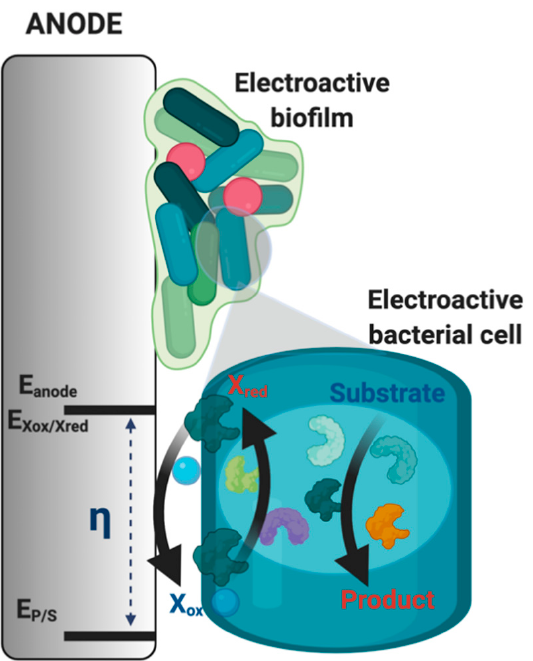
Figure 1. Pairing the microbial metabolism to an electrode surface (here, anode). Made with BioRender.com. As bacterial cells catalyze an intracellular redox reaction, generically represented as substrate to product, electrons flow to an eventual terminal electron acceptor such as redox-active protein on the cell surface or a biomolecule (X ox going to X red ) which is then re-oxidized at the electrode surface. Therefore, the potential of the anode (E anode ) will be determined by the electrochemical potential of the terminal electron transfer reaction (E Xox/Xred ). The overpotential ( η ) will be determined by the difference between the electrochemical potential of the metabolic redox reaction initiating electron transfer (E P/S ) and the electrochemical potential of the reaction occurring at the anode surface.